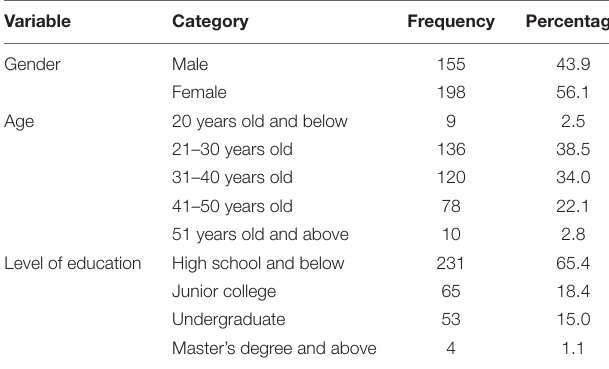
TABLE 2 | Demographic analysis ( N =